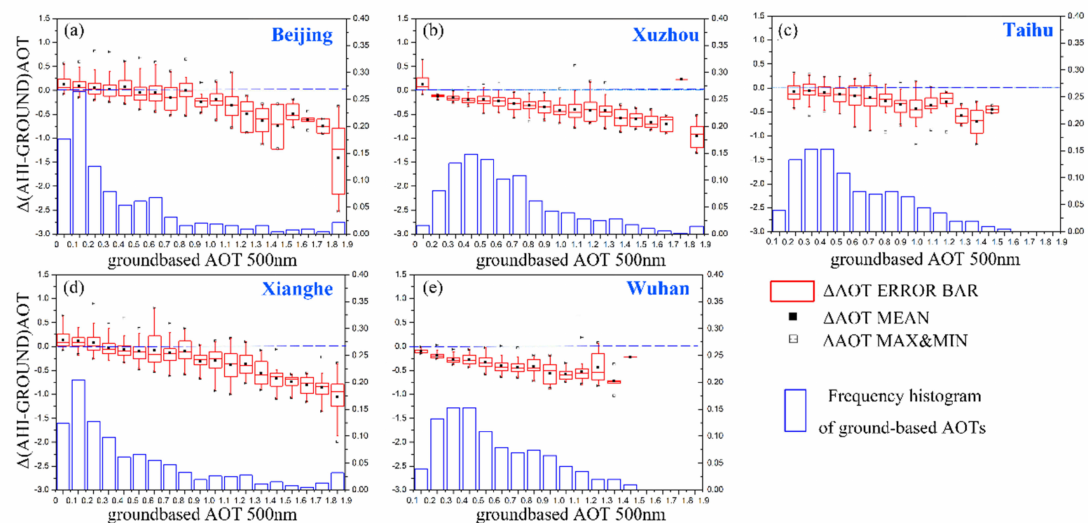
Figure 5. The di ff erence between H8 / AHI L3 AOT pure and ground-based AOTs from September 2015 to August 2016. ( a ) Beijing; ( b ) Xuzhou; ( c ) Taihu; ( d ) Xianghe; ( e ) Wuhan. The di ff erence is estimated by the best linear fit to 1 standard deviation of the biases (top–bottom intervals of the red vertical rectangle), median (short middle line in the vertical red rectangles), the means of the D-value in each frequency interval (black square points), max & min observations (grey square points) of the left-hand axis and labels. The bottom blue columns represent the sampling frequency by 0.1 increments (horizontal axis) of the right-hand axis and